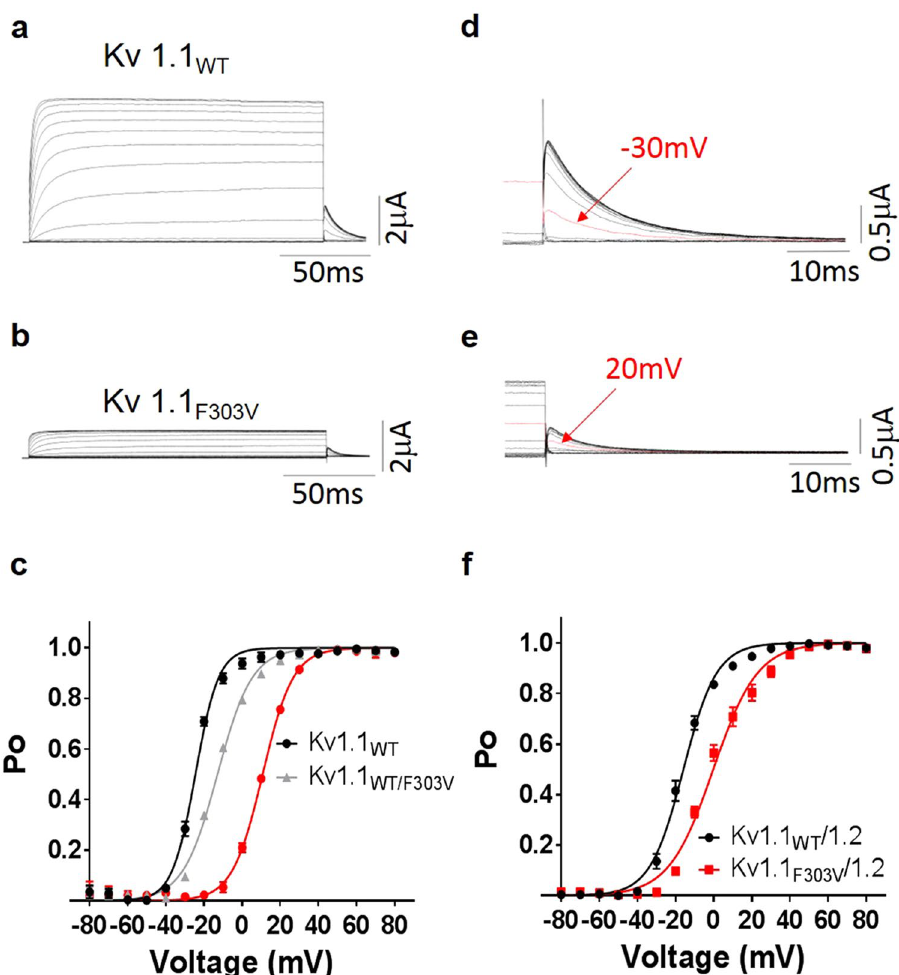
Figure 4. Effect of F303V on the voltage-dependence of current activation. Representative Kv1.1 WT ( a ) and Kv1.1 F303V ( b ) whole-cell current families. Tail currents for Kv1.1 WT (d) and Kv1.1 F303V (e) were recorded at − 50 mV preceded by several pre-pulse voltage commands. Arrows point out tail current amplitudes recorded after the indicated pre-pulse voltage commands. Kv1.1 ( c ) and Kv1.1/1.2 ( f ) activation (Po-V) curves derived from peak amplitudes of tail currents plotted as a function of pre-pulse potentials, and fitted with a Boltzmann function. For homomeric and heteromeric channels F303V mutation resulted in a right shift of the open probability curve to more positive potentials.